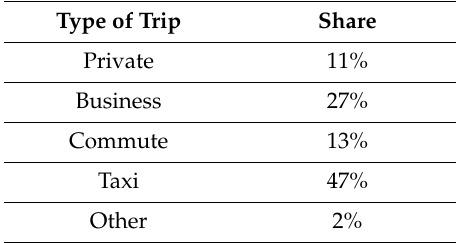
Table 3. Distribution of trip purpose.